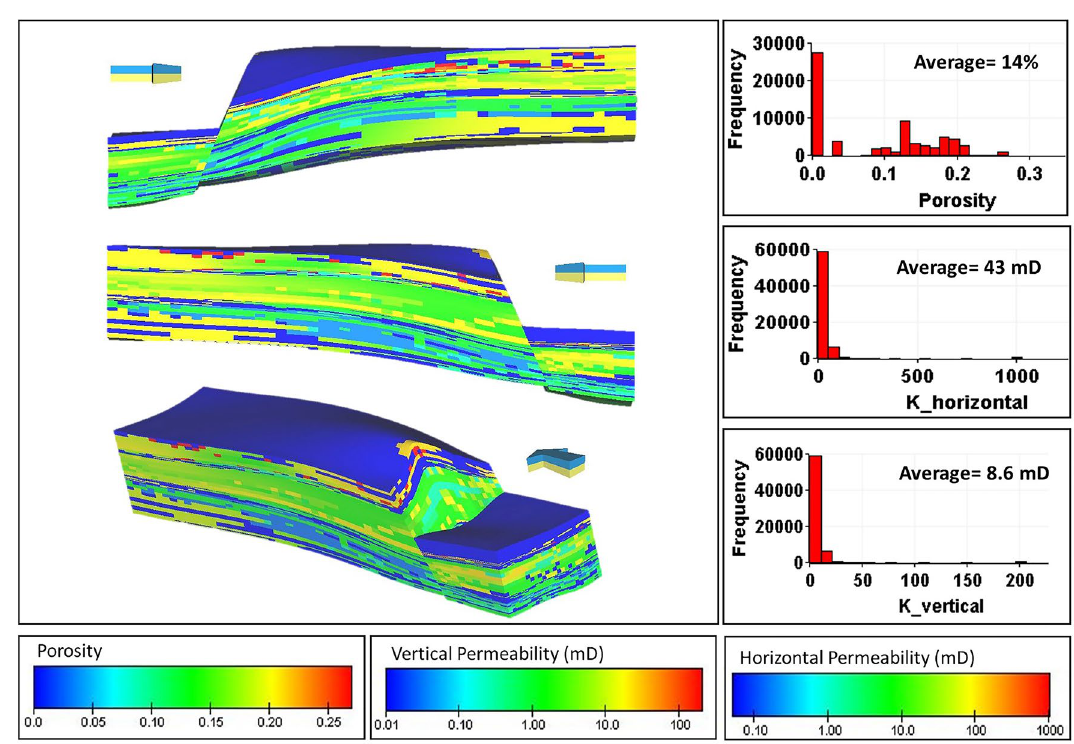
Fig. 4 Spatial distribution of the porosity, horizontal and vertical permeability of the simulation model